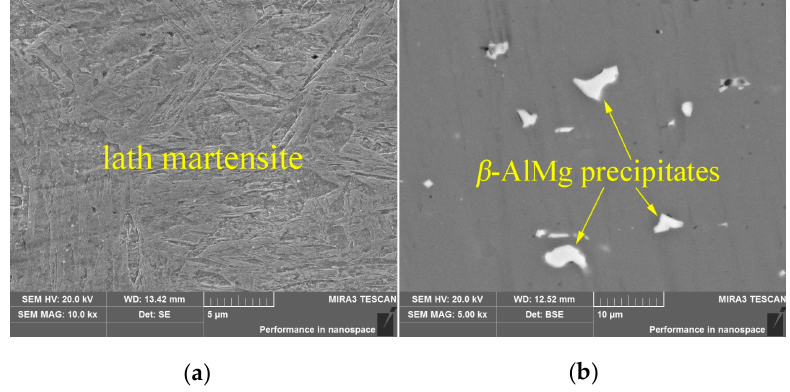
Figure 1. The microstructure of ( a ) press-hardened steel and ( b ) 5052 aluminum alloy.